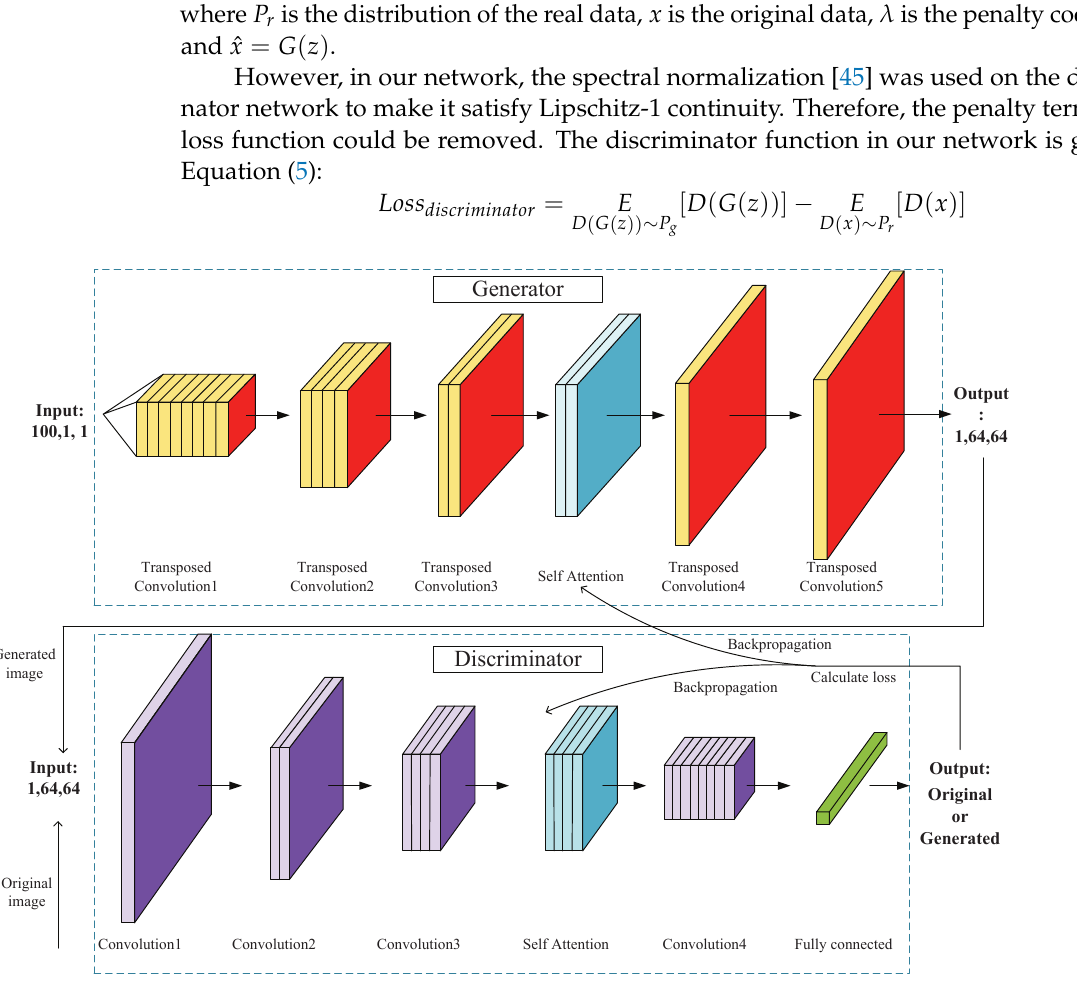
Figure 4. The overall structure and calculation process of SAGAN. The input of SAGAN is a 100 × 1 × 1 tensor of noise and the output is a 64 × 64 gray-scale